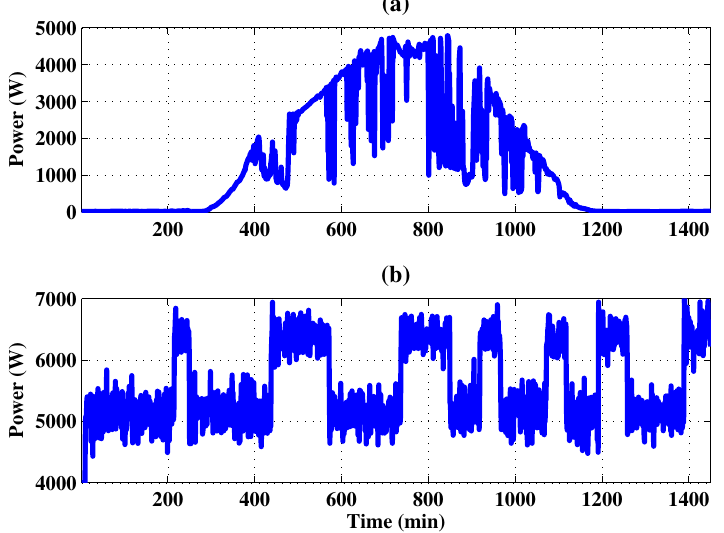
Figure 4. ( a ) Solar power available and ( b ) load profiles for simulated 1440 min